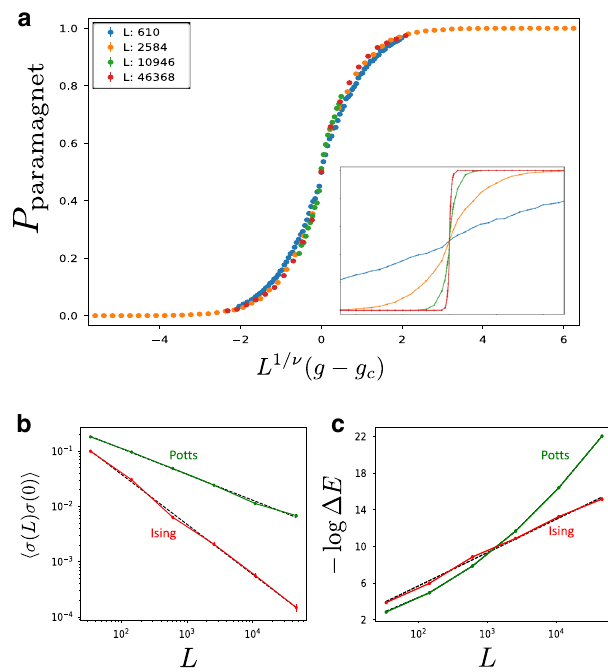
Fig. 2 Quasiperiodic Potts ( q = 3) and Ising ( q = 2) chains. For the Ising chain we choose a potential with both positive and negative couplings, whereas for the Potts chain all couplings are taken to be antiferromagnetic. a Scaling collapse of the probability of the RG to end in a paramagnetic phase for the Potts model, with ν = 1. Here, g = W h / W J is an asymmetry parameter between h i and J i with W J,h the amplitude of the quasiperiodic potentials and g c = 1. Inset: Raw, uncollapsed data. b Spin – spin correlation function σ L ð Þ σ 0 ð Þh i averaged over the uncorrelated phases θ J , θ h , scaling as L − 0.47 for Potts (in good agreement with (6) derived for discrete Fibonacci sequences) and L − 0.9 for Ising. Error bars represent SE. c Energy-length scaling: Δ E ~ L − 0.22 ln L for Potts, whereas the Ising transition has a fi nite dynamical exponent z ≈